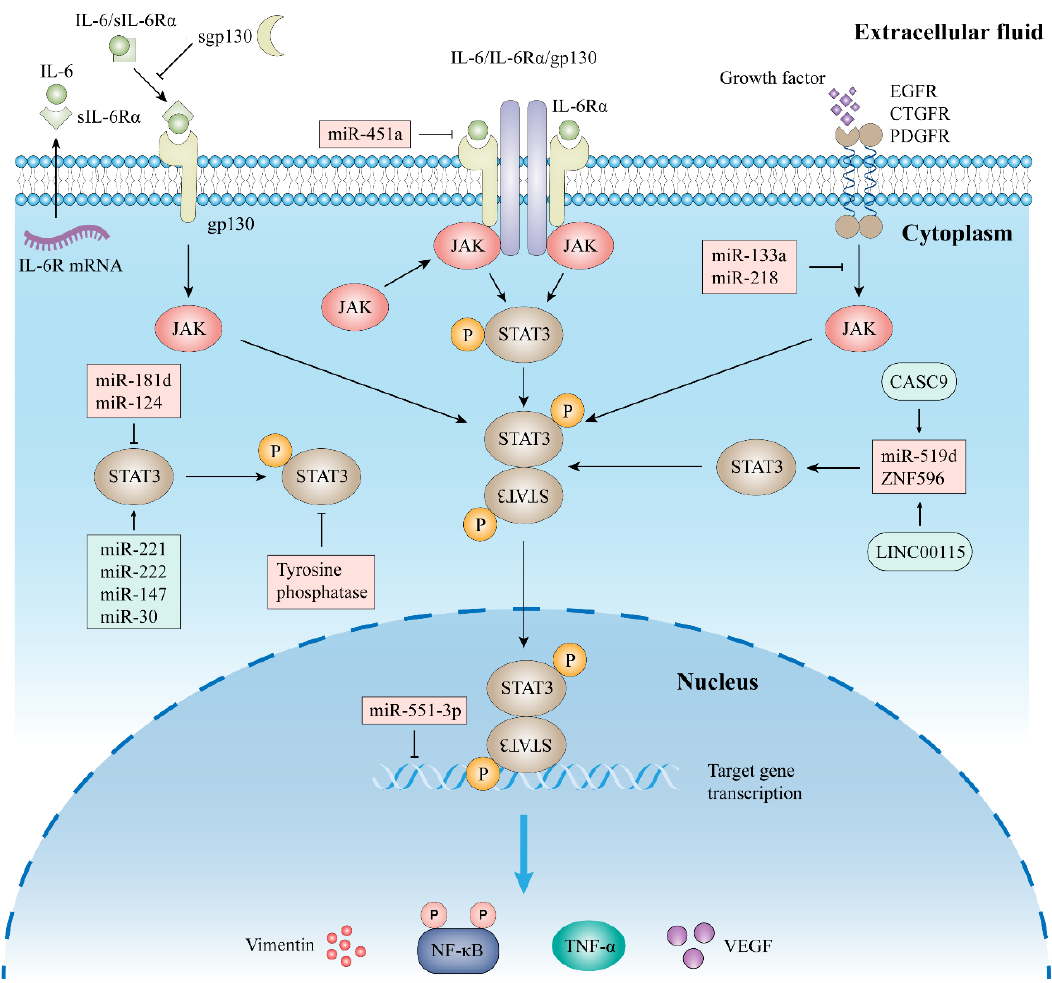
Figure 2. IL-6/JAK/STAT3 signaling pathway. IL-6 binds to the IL-6 receptor α (IL-6R α ), thereby inducing the formation of a complex consisting of two molecules each of IL-6, IL-6R, and GP130. Formation of this complex leads to activation of the JAK/STAT3 signaling pathway, resulting in the transcription of STAT3 target genes. Some growth factors can also activate the JAK/STAT3 pathway. Soluble IL-6R (sIL-6R) can be generated by alternative splicing of IL6R mRNA. sIL-6R binds to IL-6 to form a complex that binds and induces dimerization of GP130, leading to activation of downstream signaling pathways. Once bound to gp130, STAT3 is phosphorylated by JAK at tyrosine 705, leading to STAT3 dimerization and nuclear translocation, followed by STAT3-mediated transcription of target genes. Some molecules, such as miR-181d, miR-124, miR-451a, miR-551-3p, and tyrosine phosphatase can inhibit the STAT3 pathway. MiR-211, miR-222, miR-147, and miR-30 can promote STAT3 gene expression. When STAT3 is activated, it can promote the function of downstream molecules. Abbreviations: miR, microRNA; EGFR, epidermal growth factor receptor; CTGFR, connective tissue growth factor receptor; PDGFR, platelet-derived growth factor receptor. Overexpression of STAT3 in macrophages can also inhibit the antitumor immune function of T cells. STAT3 can directly induce CD163 expression in macrophages [47]. When STAT3 activity is increased in macrophages, the immune response process of T cells is impaired